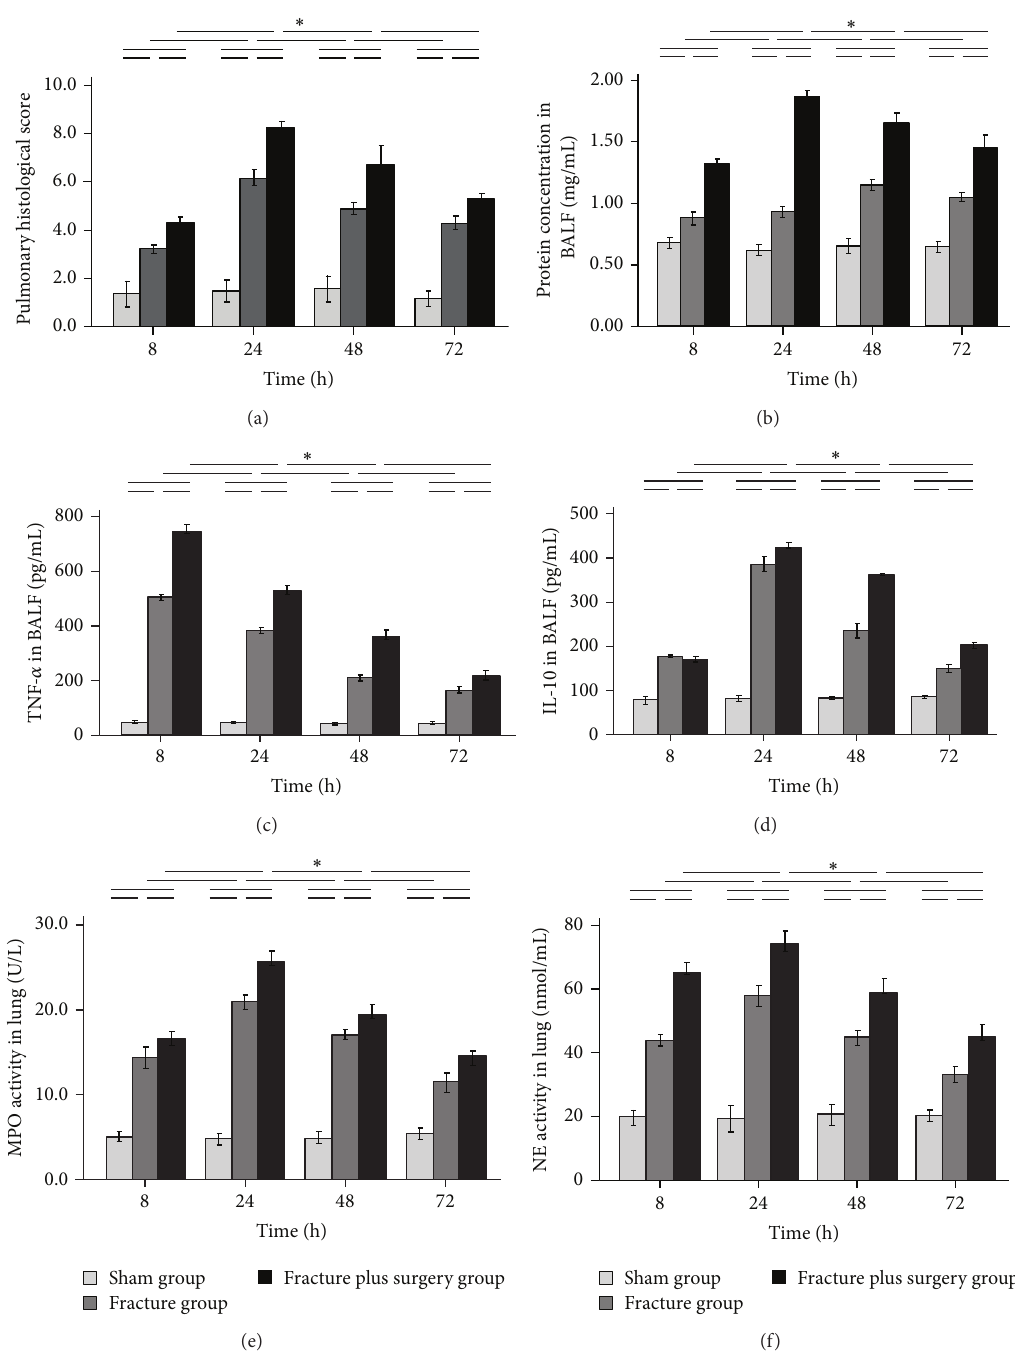
Figure 3: Time course of the pulmonary histological score (a), the protein (b), TNF- 𝛼 (c), and IL-10 (d) concentrations in BALF and the lung tissue MPO (e) and NE (f) activity. Results are expressed as mean ± standard error. ∗ 𝑃 < 0.05 when compared to other